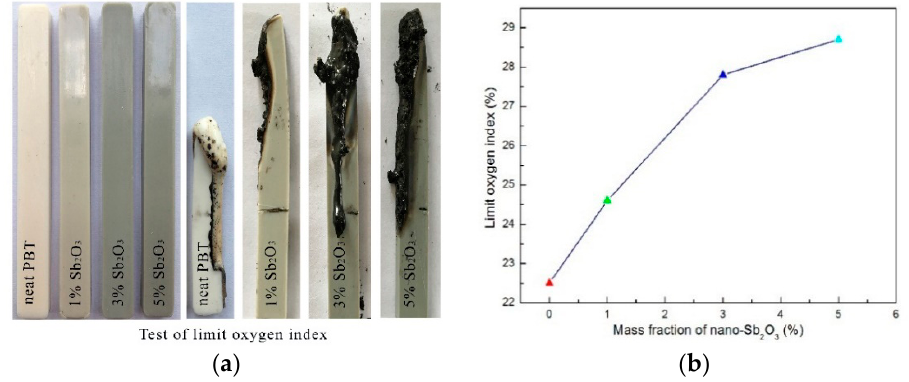
Figure 6. LOI of the neat PBT and its composites. ( a ) images of burnt samples before and after LOI test ( b ) curve of limit oxgen index with different mass fraction of nano-Sb 2 O 3.